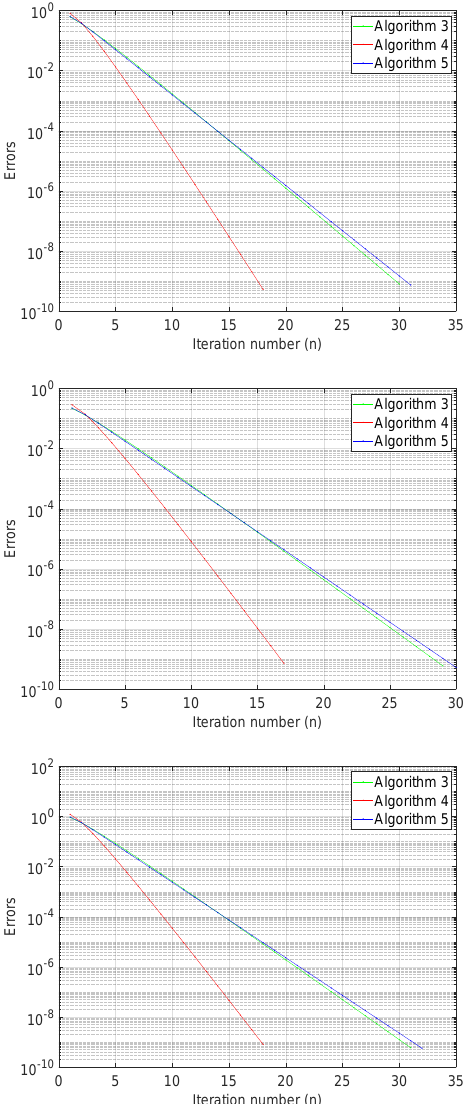
Figure 2. Top: Case I; Middle: Case II; Bottom: Case III.